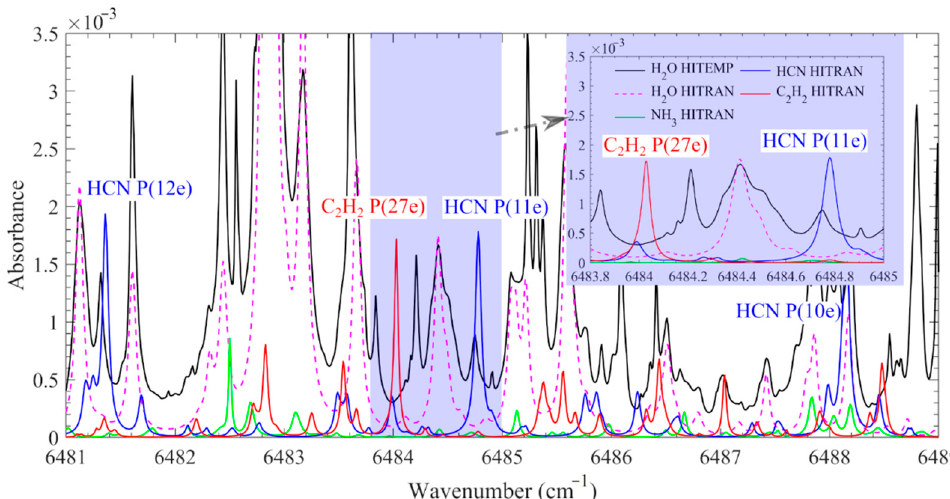
Figure 2. Calculated absorbance of 1000 ppm HCN, C 2 H 2 , NH 3 , and 10% H 2 O over 6481–6489 cm − 1 at 1200 K and atmospheric pressure with an optical path length of 0.34 m. The spectra data from the HITRAN2016 and HITEMP2010 databases were used for spectral simulation. Spectra with high-resolution at 6483.8–6485 cm − 1 are shown in the inset.